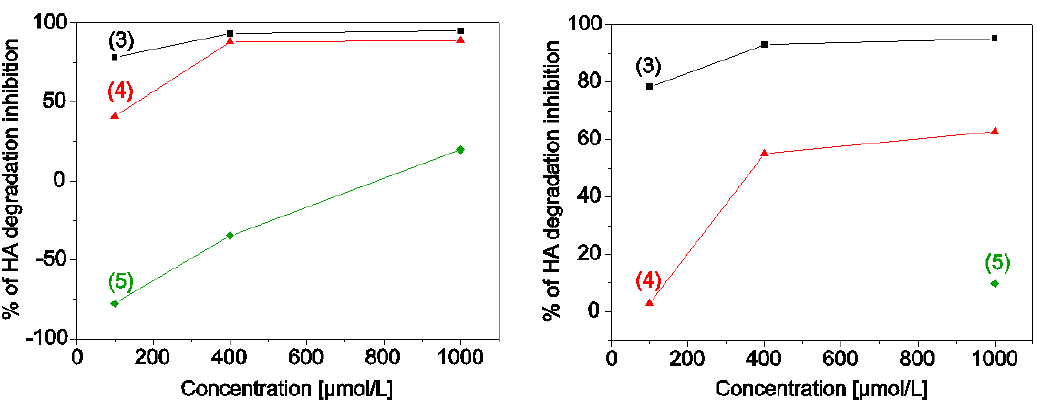
Figure 2. Percentage of inhibition of HA degradation within 120 min. Stobadine · 2HCl dihydrochloride, i.e., compound ( 3 ), and two of its derivatives (( 4 ) and ( 5 )) were examined as preventive antioxidants (left panel) and chain-breaking antioxidants (right panel).